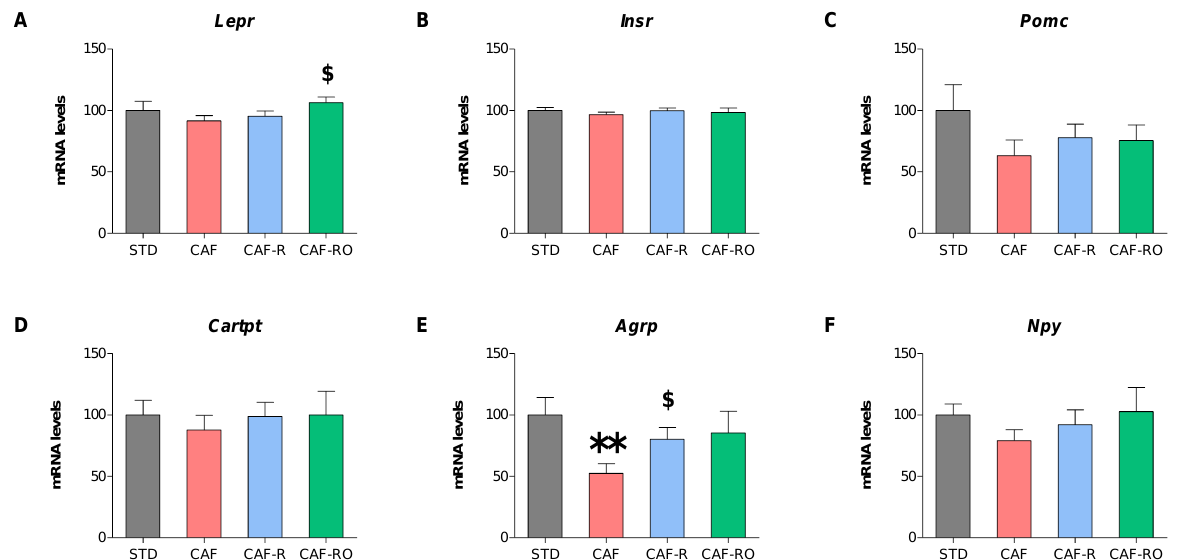
Figure 3. Effects of the dietary treatments on the HPT mRNA levels of Lepr ( A ), Insr ( B ), Pomc ( C ), Cartpt ( D ), Agrp ( E ) and Npy ( F ). Lepr , leptin receptor; Insr , insulin receptor; Pomc , proopiomelanocortin; Cartpt , cocaine- and amphetamine-regulated transcript; Agrp , agouti-related peptide; Npy , neuropeptide Y. Data are expressed as the mean ± SEM and relativized to the STD values (%). ** p < 0.01 vs. STD group; $ p < 0.05 vs. CAF group.